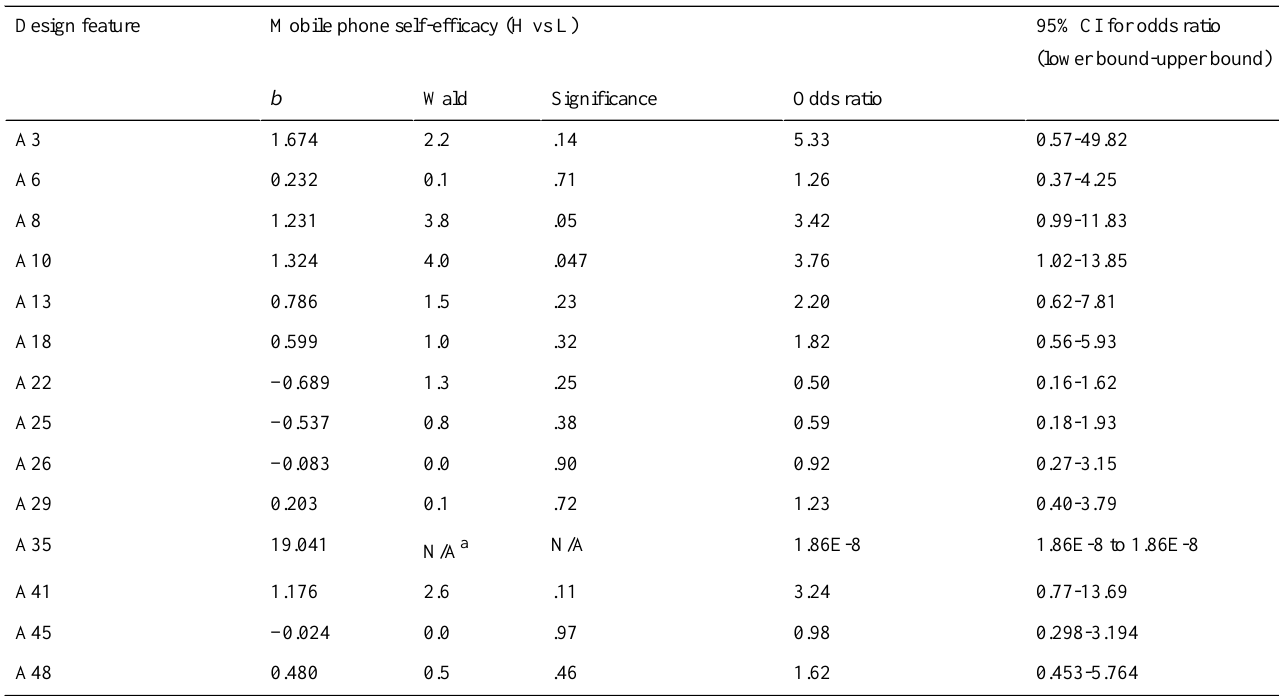
Table 17. Parameter estimates of change of Mobile phone self-efficacy (MPSE) from low to medium ( valued [ attractive + one-dimensional ] over indifferent ).